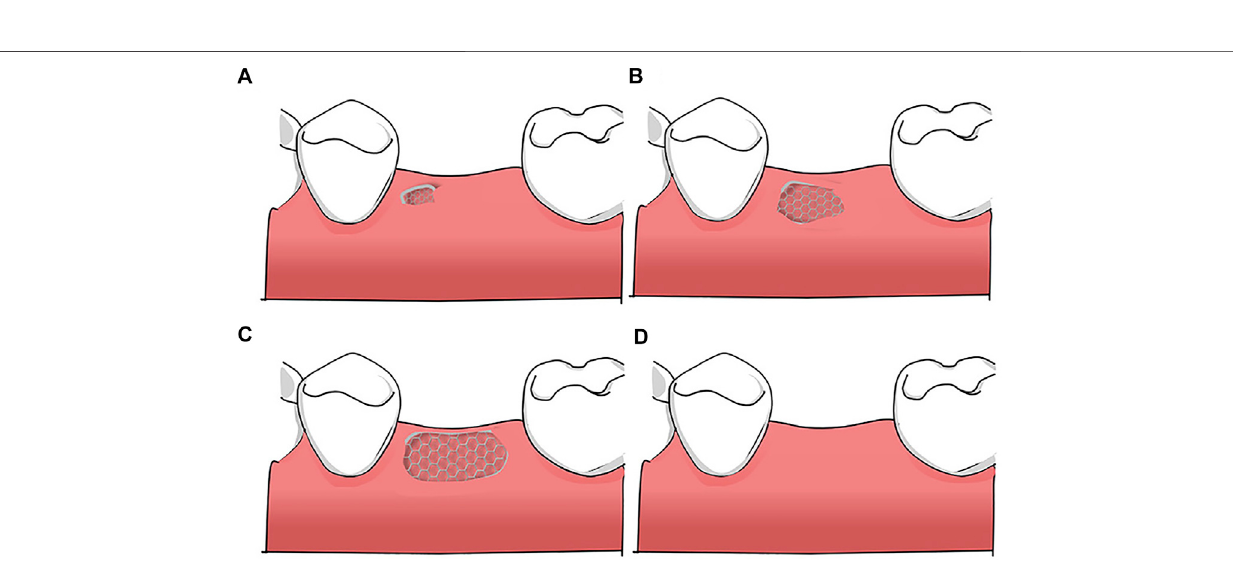
Frontiers in Bioengineering and Biotechnology |